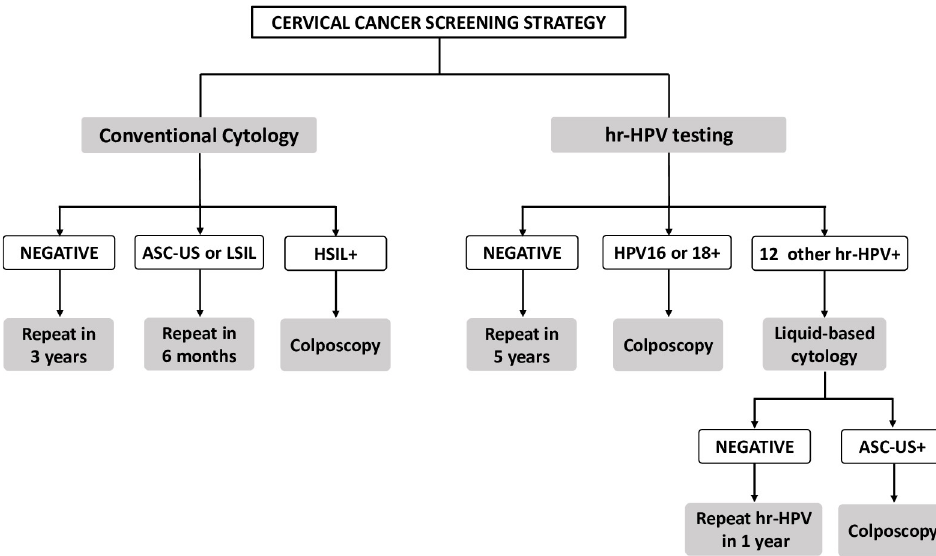
Fig 1. Cervical cancer screening strategies: Conventional cytology (right) and primary hrHPV test (left). The hybrid strategy is a mix of cytology for women aged 25 to 29 years and hrHPV test for women aged 30 to 64 years.